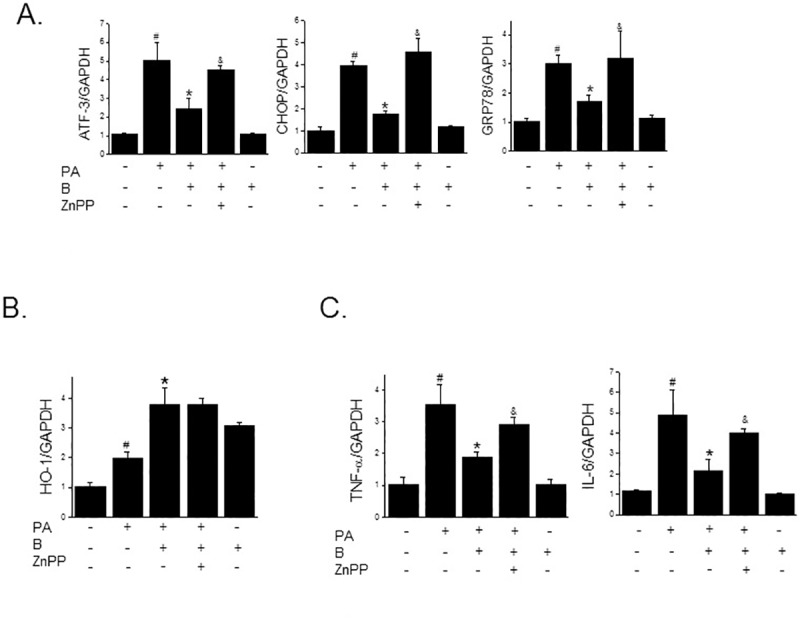
Effects of baicalein on PA-induced lipotoxicity in isolated pancreatic islets.Pancreatic islets isolated from C57BL/6J mouse (9 weeks old, male) were pretreated with or without ZnPP (10 μM) for 30 min, followed by baicalein (50 μM) for 3 h and then PA (500 μM) for a further 8 h. The mRNA expressions of HO-1 (B) or ER stress (A) and proinflammatory markers (C) were assessed by qPCR. The results shown are representative of three independent experiments and are expressed as means ± SDs. #P<0.05 vs. controls; *P<0.05 vs. PA alone; &P<0.05 vs. PA plus baicalein treatment.